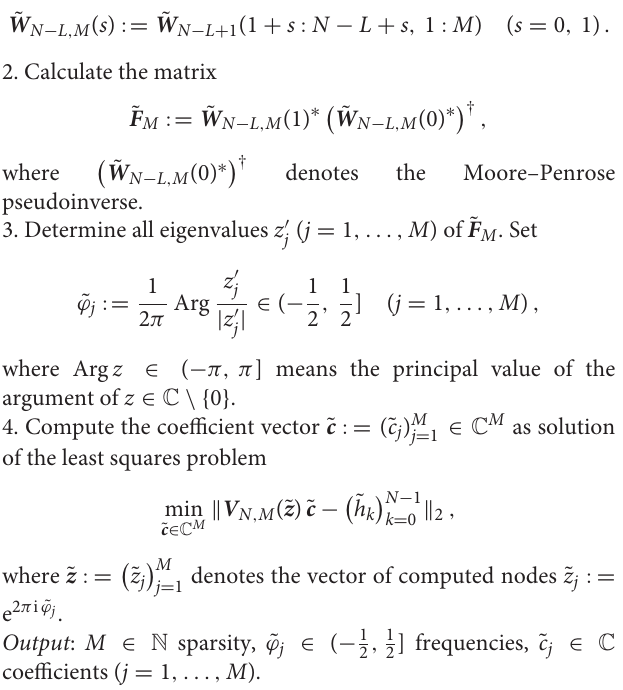
Algorithm 2.9 (ESPRIT via SVD)